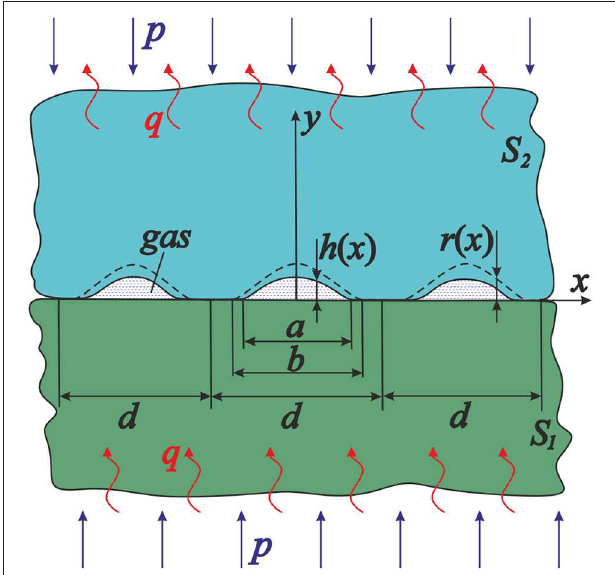
Two opposite directions of heat flow are considered: heat flows from body S 1 into body S 2 when q > 0 (as in Figure 2 ), and heat flows from body S 2 into body S 1 when q <